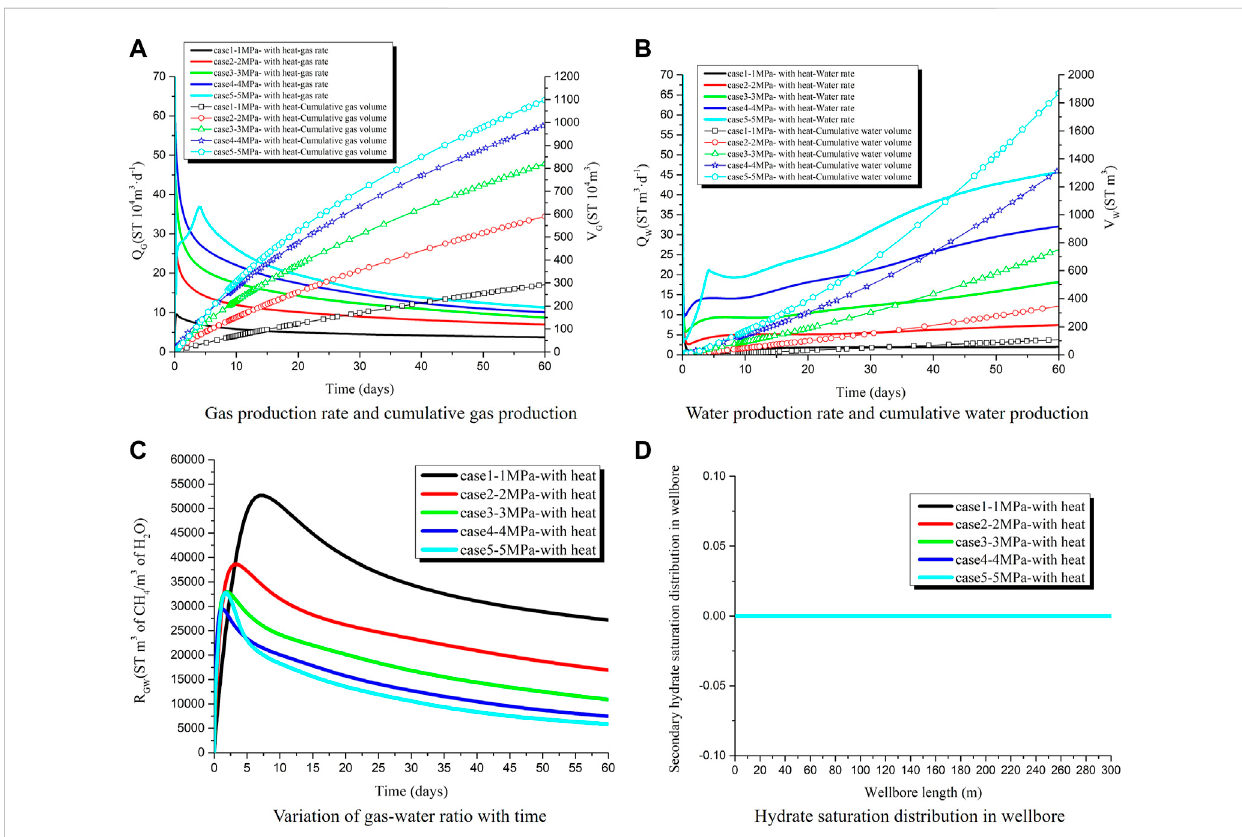
FIGURE 12 Gasproductionrateandcumulativegasproduction (A) ,waterproductionrateandcumulativewaterproduction (B) ,variationofgas-waterratiowith time (C) , and hydrate saturation distribution in wellbore (D) after 60 days of depressurization production with different production system (with